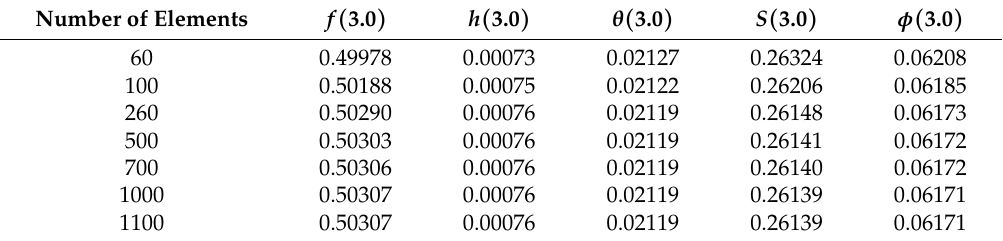
Table 1. FEM convergence results for active control of nanoparticles when Pr = 0.773; M = 2; B m =